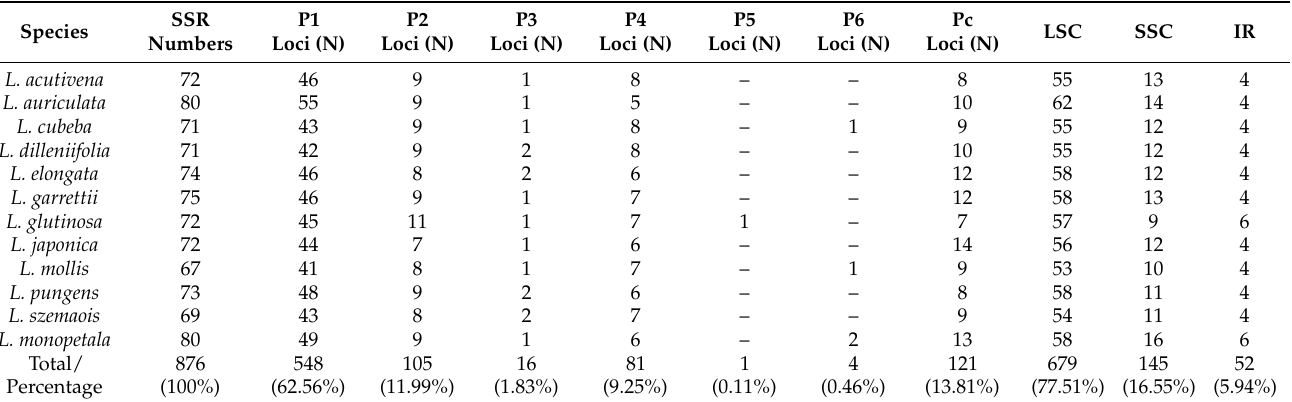
Table 3. Summary of the simple sequence repeats (SSR) in 12 Litsea